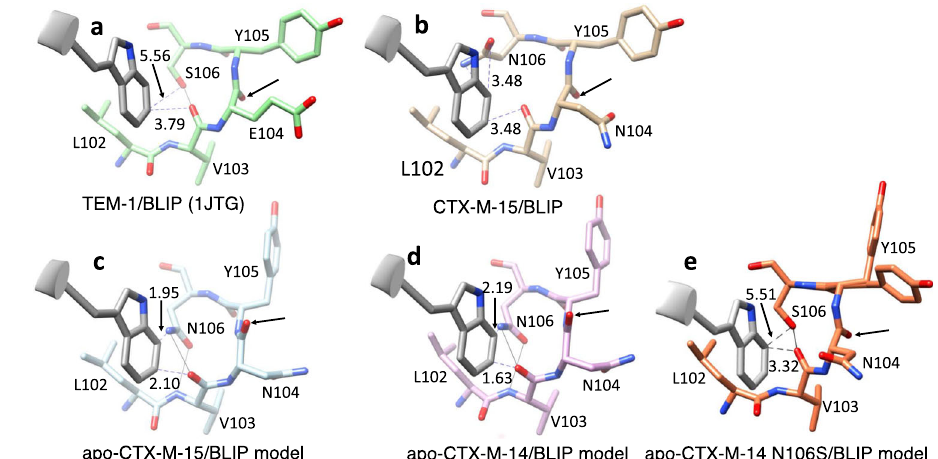
Fig. 6 | Structures and structural alignments of the interaction of BLIP Trp112 withtheTEM-1,CTX-M-15,andCTX-M-14 β -lactamases.a StructureofBLIP(gray) in complex with TEM-1 β -lactamase (green) showing the interaction of BLIP Trp112 with the β -lactamase 103 – 106 loop region (PDB id:1JTG). b Structure of CTX-M-15 (tan) in complex with BLIP showing the BLIP Trp112 interaction with the 103 – 106 loop. c Structure alignment of CTX-M-15 apo-enzyme (blue) (PDB id:4HBT) with CTX-M-15 in the CTX-M-15/BLIP structure. CTX-M-15 from the BLIP structure is not shown for clarity. d Structure alignment of CTX-M-14 apo-enzyme (pink) (PDB id:1YLT)withCTX-M-15intheCTX-M-15/BLIPstructure.CTX-M-15 β -lactamasefrom the BLIP structure is not shown for clarity. e Structure alignment of CTX-M-14